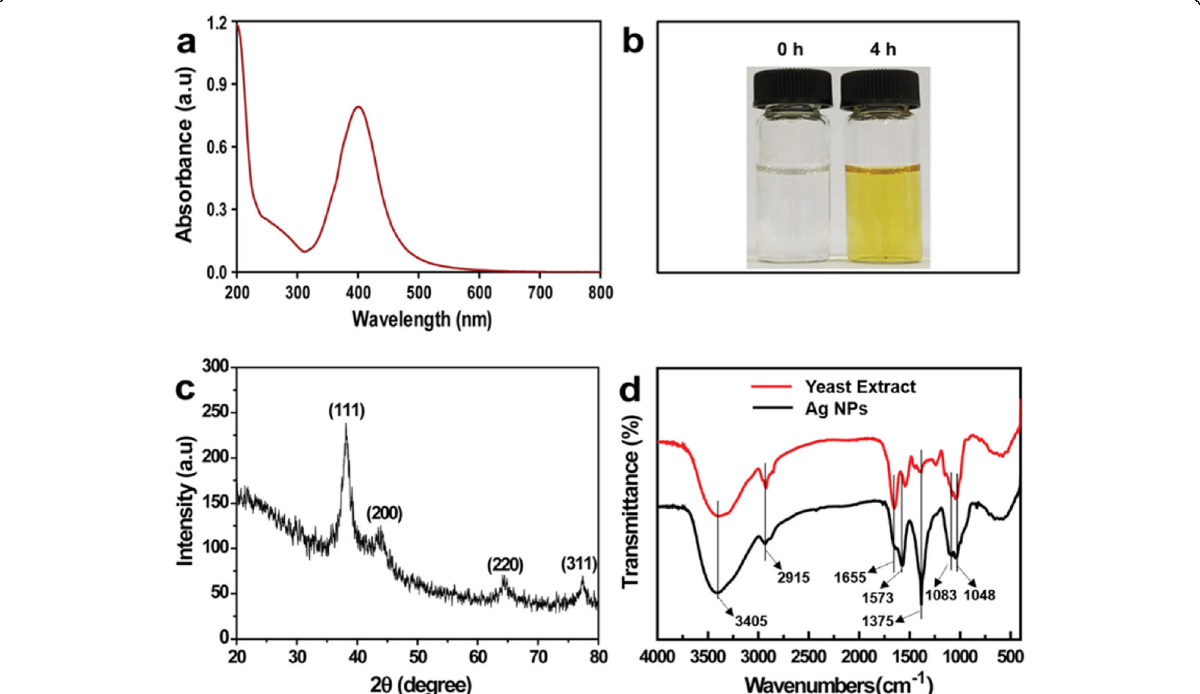
Fig. 3 a UV-Vis spectrum of Ag NPs, b photo of synthesized Ag NPs, c XRD pattern of Ag NPs, and d FTIR spectrum of Ag NPs and yeast extract